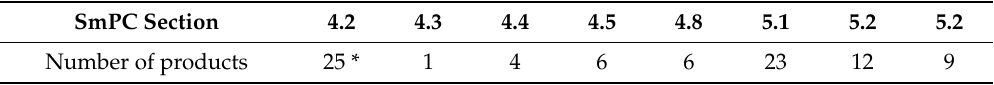
Table 5. Sections of the SmPC containing relevant paediatric information for all medicines containing cardiovascular drugs with a positive PIP decision associated. Data taken from European Public Assessment Reports (EPARs) for those products [20]. See methods for details of data mining. * Products providing paediatric dosing instructions were evolucumab, rosuvastatin, and